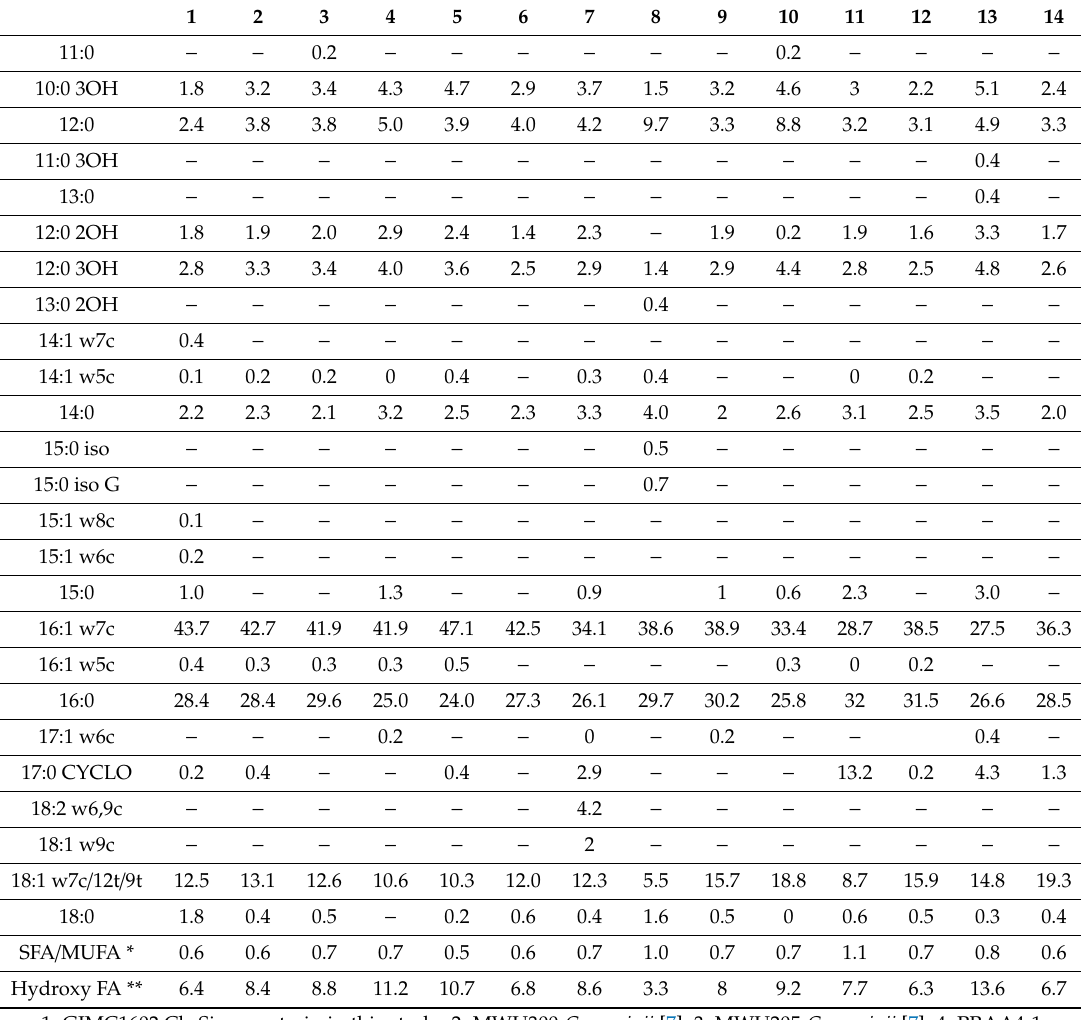
Table 3. Fatty acid compositions of Chromobacterium